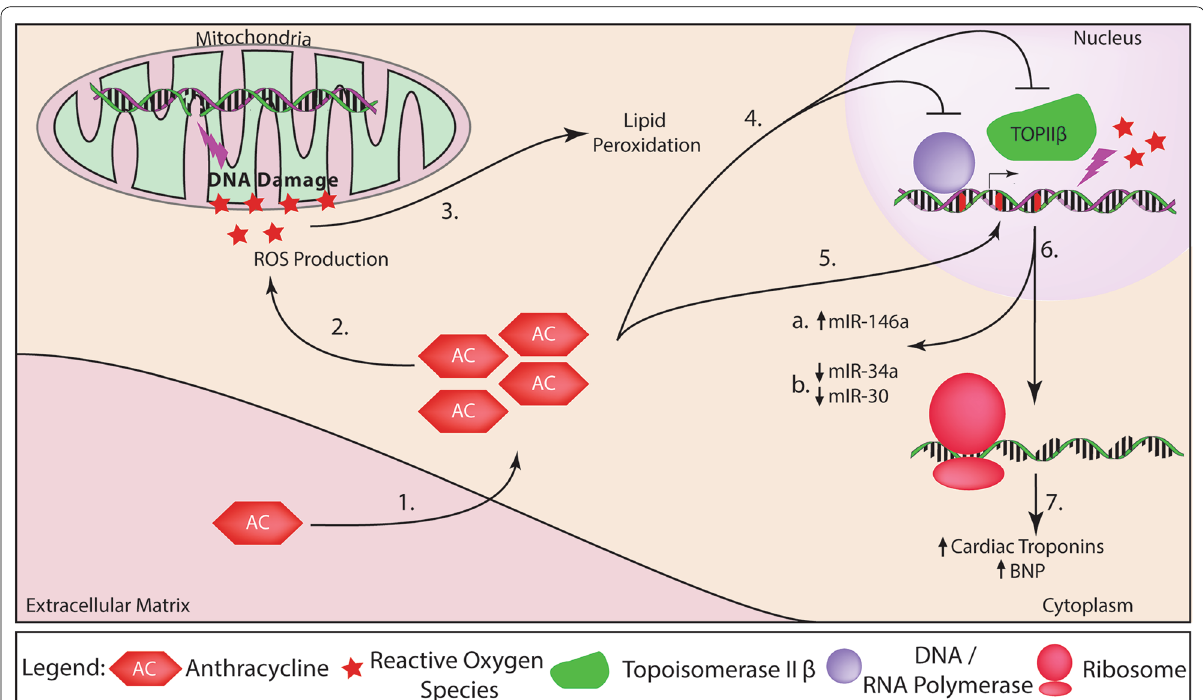
Fig. 1 Actions of anthracyclines within the cell. Anthracyclines (ACs) enter the cell, cause mitochondrial damage, and impair transcription in nuclear DNA. 1 In healthy cells, ACs enter the cell’s cytoplasm and has cytotoxic effects. 2 Products from AC‑induced ROS (reactive oxygen species) damage mitochondrial DNA leading to mitochondrial dysfunction. 3 ROS‑induced generation of oxidized lipid further damages the host‘s cells. 4 AC also inhibits DNA/RNA synthesis by impairing the initiation or elongation phases during DNA synthesis and blocking transcription factor bind‑ ing or RNA polymerase activity during RNA synthesis. Additionally, intercalation of AC within the DNA can inhibit Topoisomerase II β (TOP2β) by activating the DNA‑damage response that leads to cell death. 5 DNA intercalation further impairs normal DNA/RNA synthesis. 6 ACs can function as transcriptional inhibitors and/or modifiers for translational transcripts: ( a ) miR‑146a is a negative regulator for epithelial growth factor receptor 4 (ErbB4) and is upregulated shortly after AC exposure. ( b ) Both miR‑30 and miR‑34a are direct regulators for cell apoptosis and are downregulated shortly after AC treatment in humans and mice. As a result of cardiac injury, troponins and BNP are upregulated due to cardiomyocyte injury and increased circulating levels are detected. Upregulation can result from activation of pro‑apoptotic/anti‑proliferative pathways that could ultimately lead to cardiac dysfunction if not